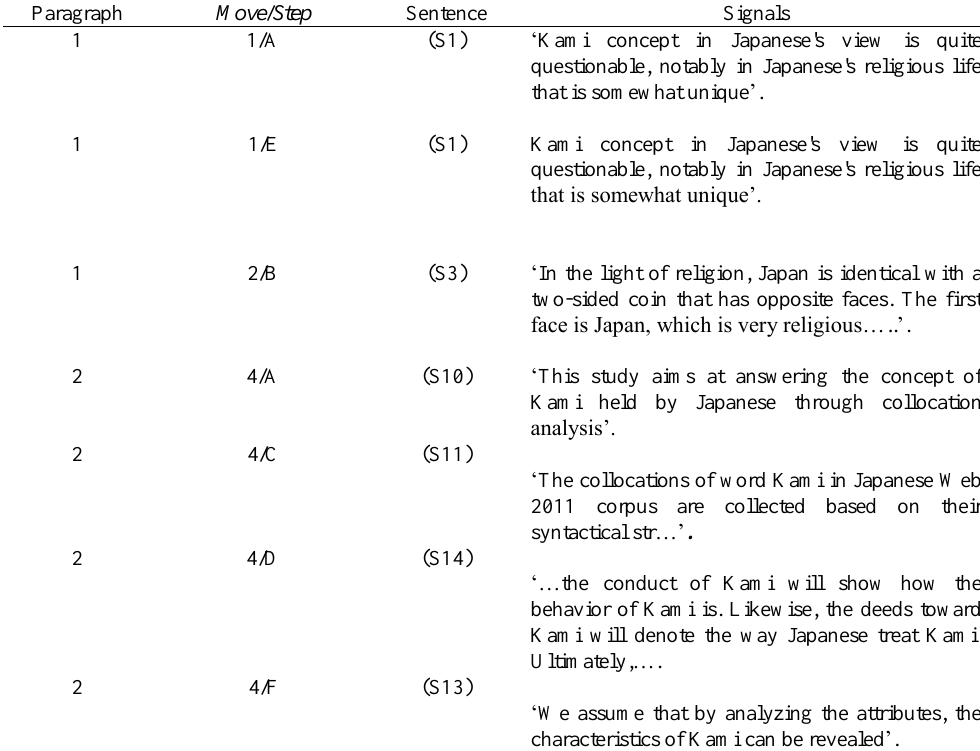
Move and Step in Research Article Introduction (RAI) in article 1.4 Research article